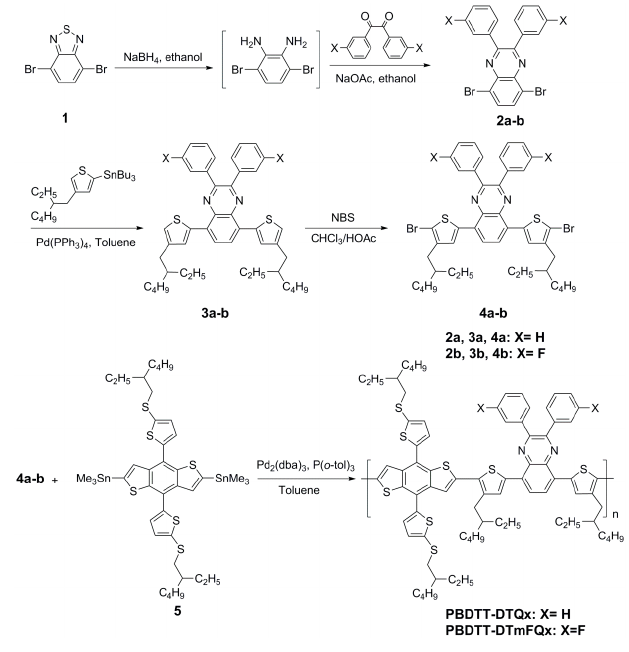
Scheme 1. Synthetic routes of the copolymers.